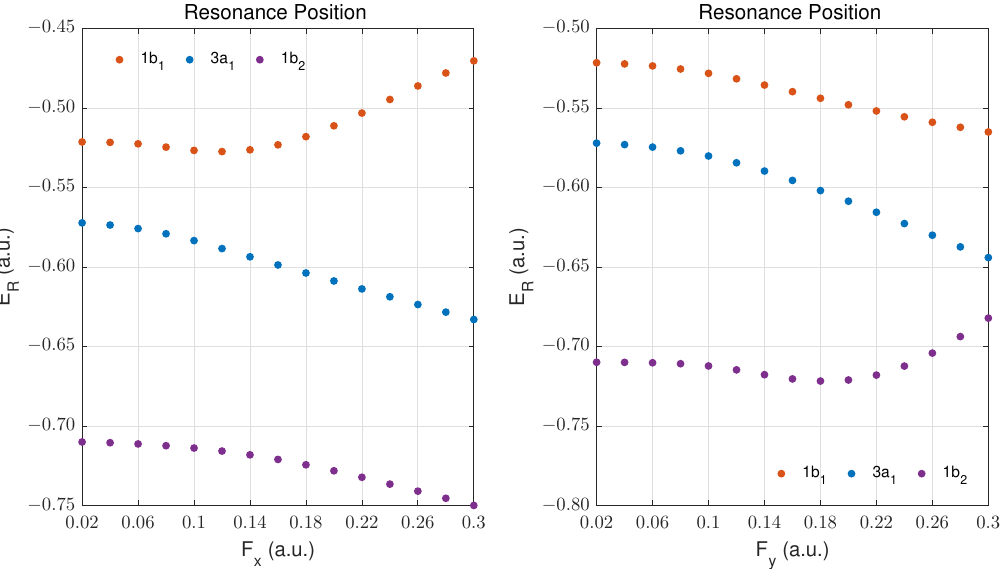
Figure 10. Resonance positions for the three valence MOs exposed to a field along the x -axis ( left panel ) and y -axis ( right panel ), respectively. These axes are symmetry axes, so there is no dependence on the sign of the